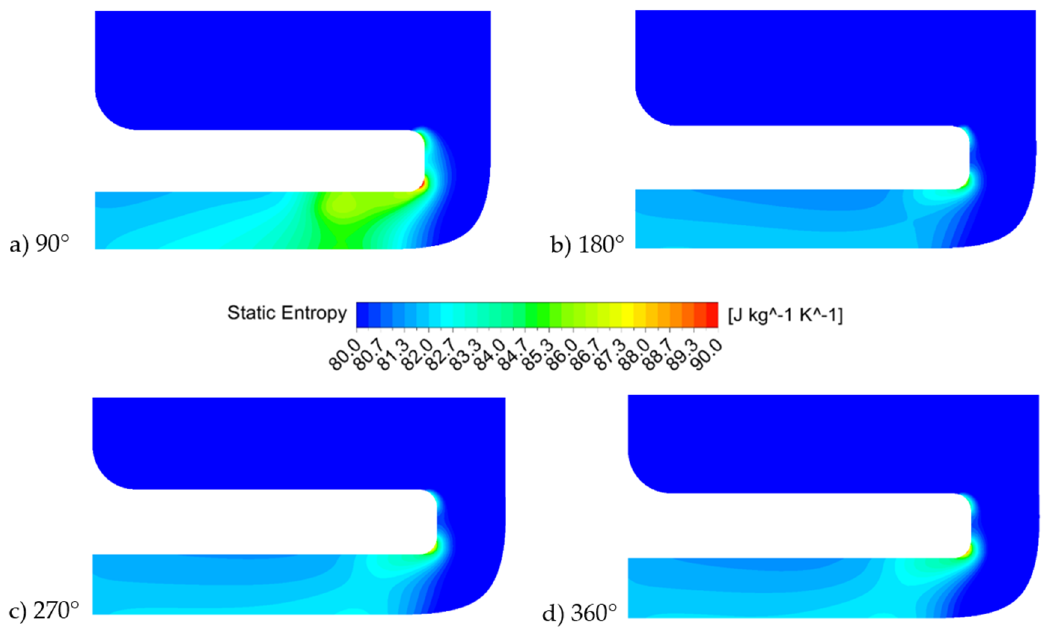
Figure 5. Contours of static entropy for different cross-sections of the scroll distributor in specific locations: ( a ) 90 ◦ ; ( b ) 180 ◦ ; ( c ) 270 ◦ and ( d ) 360 ◦